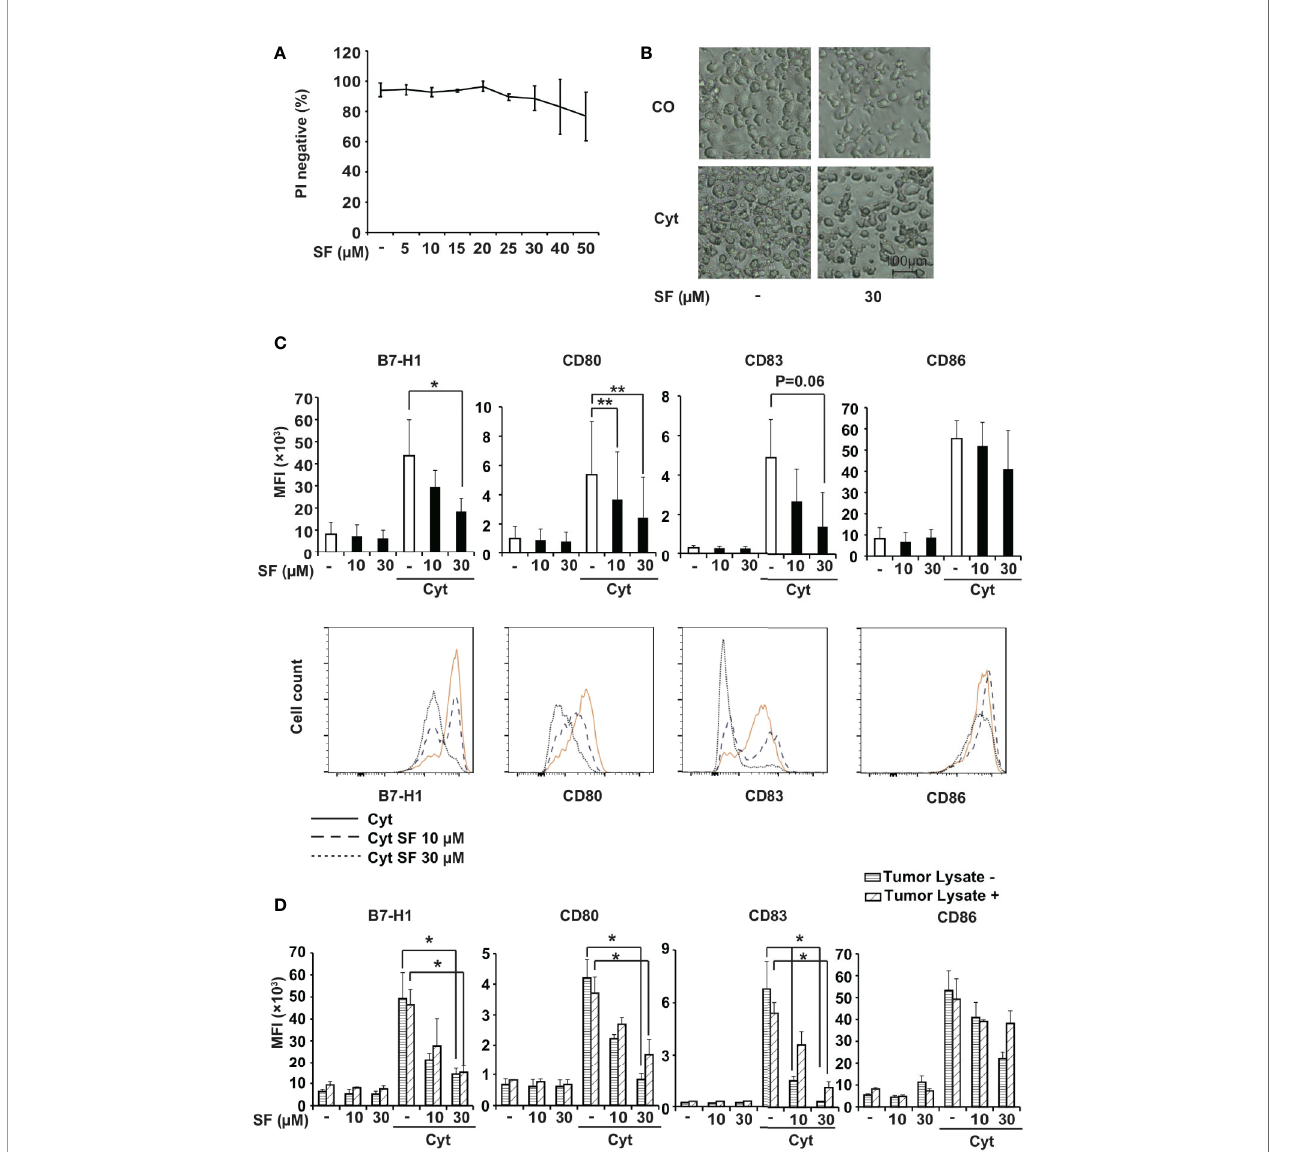
FIGURE 1 | Sulforaphane limitedly affects viability and downregulates surface molecules in monocyte-derived dendritic cells (MoDCs). (A) MoDCs were treated with vehicle control or with different concentrations of sulforaphane (SF) as indicated, and the viability was examined 48 h later by propidium iodide (PI) staining and fl ow cytometry. (B) Immature (CO) or mature (Cyt) MoDCs were treated with 30 µM sulforaphane or vehicle control for 48 h. The morphology was documented by microscopy at 100× magni fi cation. Representative images are shown. (C) MoDCs were pretreated with 10 µM, 30 µM sulforaphane or vehicle control for 30 min and treated with cytokine cocktail (Cyt) or vehicle control for 48 h. Afterwards, cells were labeled with B7-H1-PE, CD80-FITC, CD83-APC, or CD86-PE antibody and analyzed by fl ow cytometry and FlowJo software. The data are presented in mean fl uorescence intensity (MFI) ± standard deviation (SD). The histograms below provide the data from one representative experiment, n = 4, *P ≤ 0.05, **P ≤ 0.01 (D) BxPc-3 cells were frozen in a dry ice bath and thawed at 37°C water bath for 4 consecutive cycles. The BxPc-3 lysate (Tumor Lysate +) or culturing medium (Tumor Lysate -) was used to treat MoDCs for 24 h. Afterwards, the cells were treated as in 1C. The data are presented in MFI ± SD, n=3, *P ≤ 0.05, **P ≤